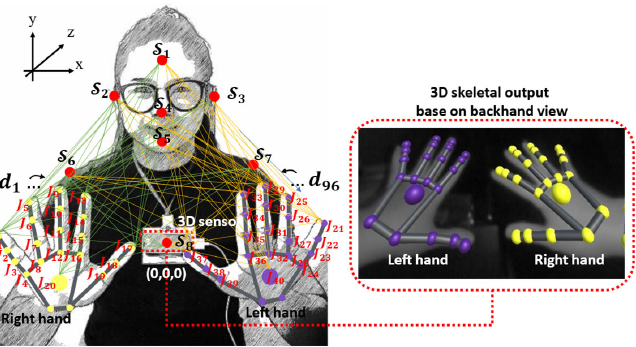
Figure 2. Spatial–temporal body parts and hand relationship patterns (ST ‐ BHR).